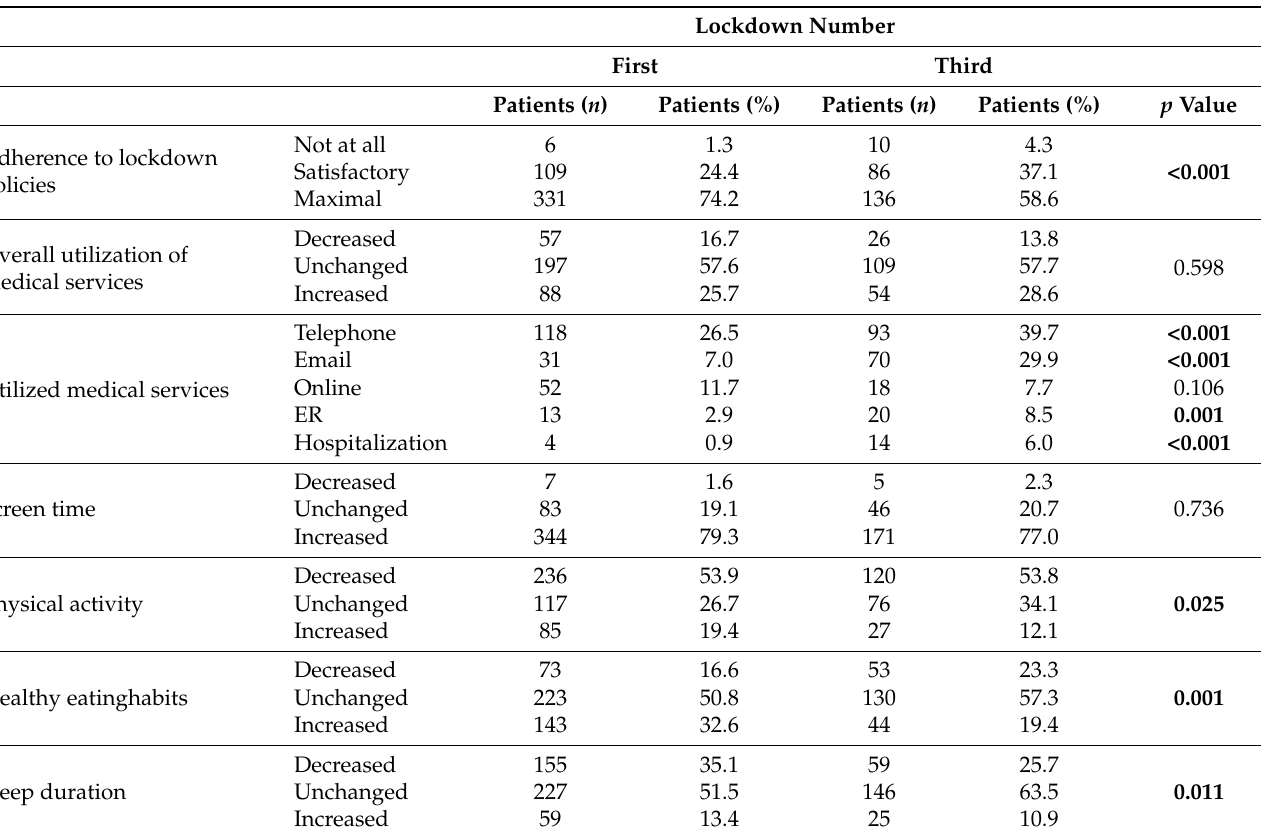
Table 3. Lockdown-related